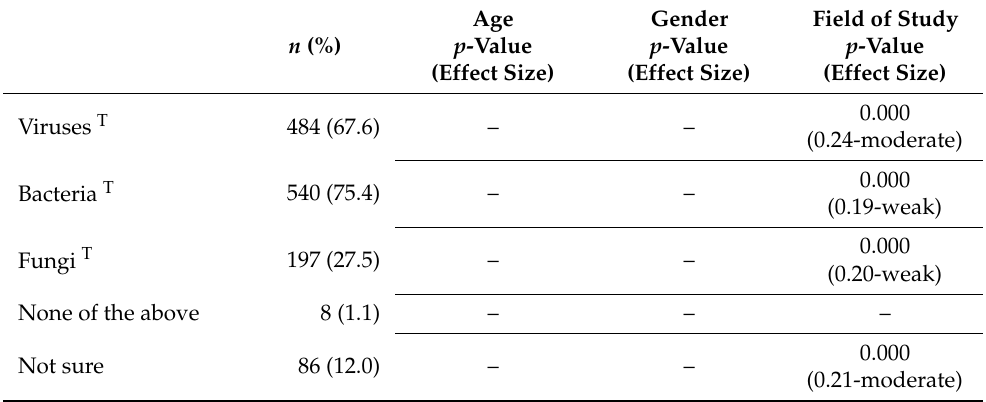
Table 3. Types of microorganisms eliminated with a water-alcohol solution, according to the partici- pants (multiple choice